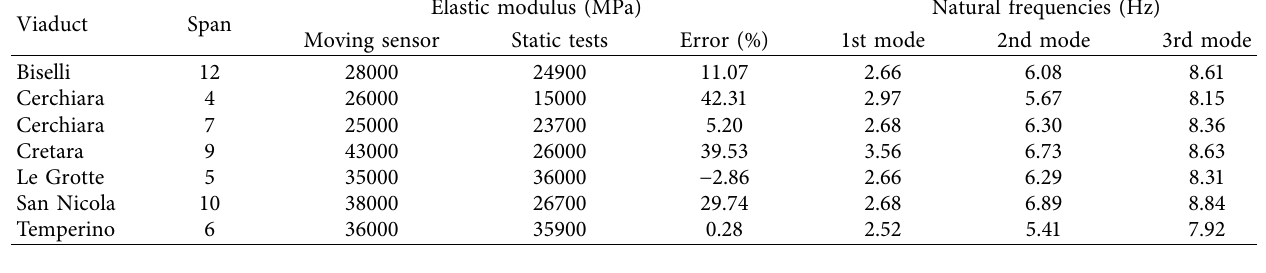
Table 1: Comparison between the elastic moduli obtained from the instrumented vehicle and the static load tests (the table reports details about the experimental natural frequencies of the first three identified modes). Elastic modulus (MPa) Viaduct Span